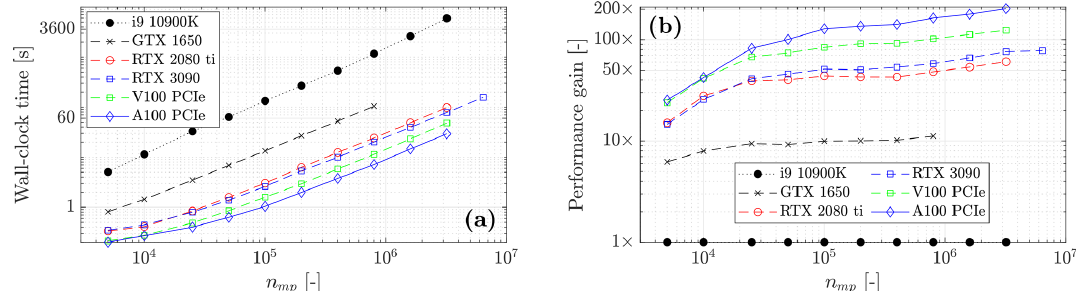
Figure 13. (a) Wall-clock time reported for various computing architectures (GPUs and CPU). The differences in the maximal number of material points n mp are due to the on-chip memory limit. A significant difference in terms of wall-clock time is observed between the CPU and GPUs, even for the low-entry consumer electronic GTX 1650, i.e. a performance gain of ≈ 10 × . (b) Performance gains of GPUs relative to the CPU, i.e. with 1 × as a baseline. We add the CPU and the GTX 1650 wall-clock time for an easier comparison.